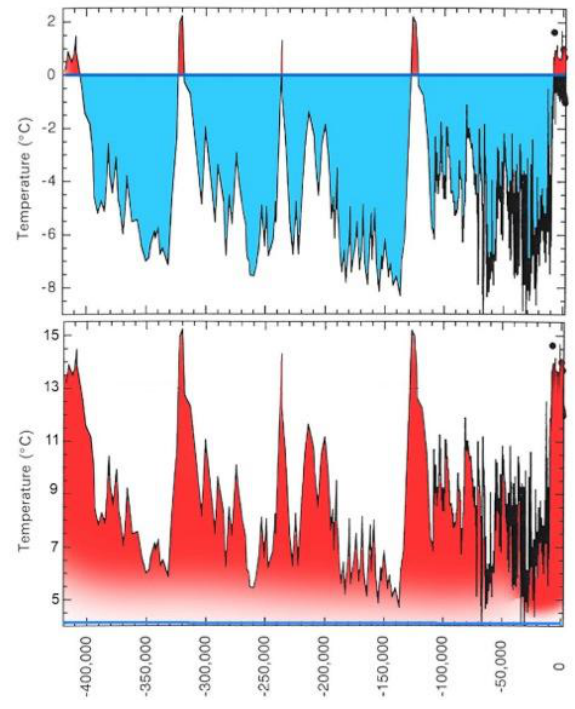
Figure 1. In the upper part, based on the standard view, there were four successive Ice Ages (painted blue) during the last 440,000 years and the intervening interglacial periods (painted red). The original figure has a black and white format (Figure 1.5 in [1]). In the lower part, the base line is chosen to be +5 °C, and the whole range of changes is painted in